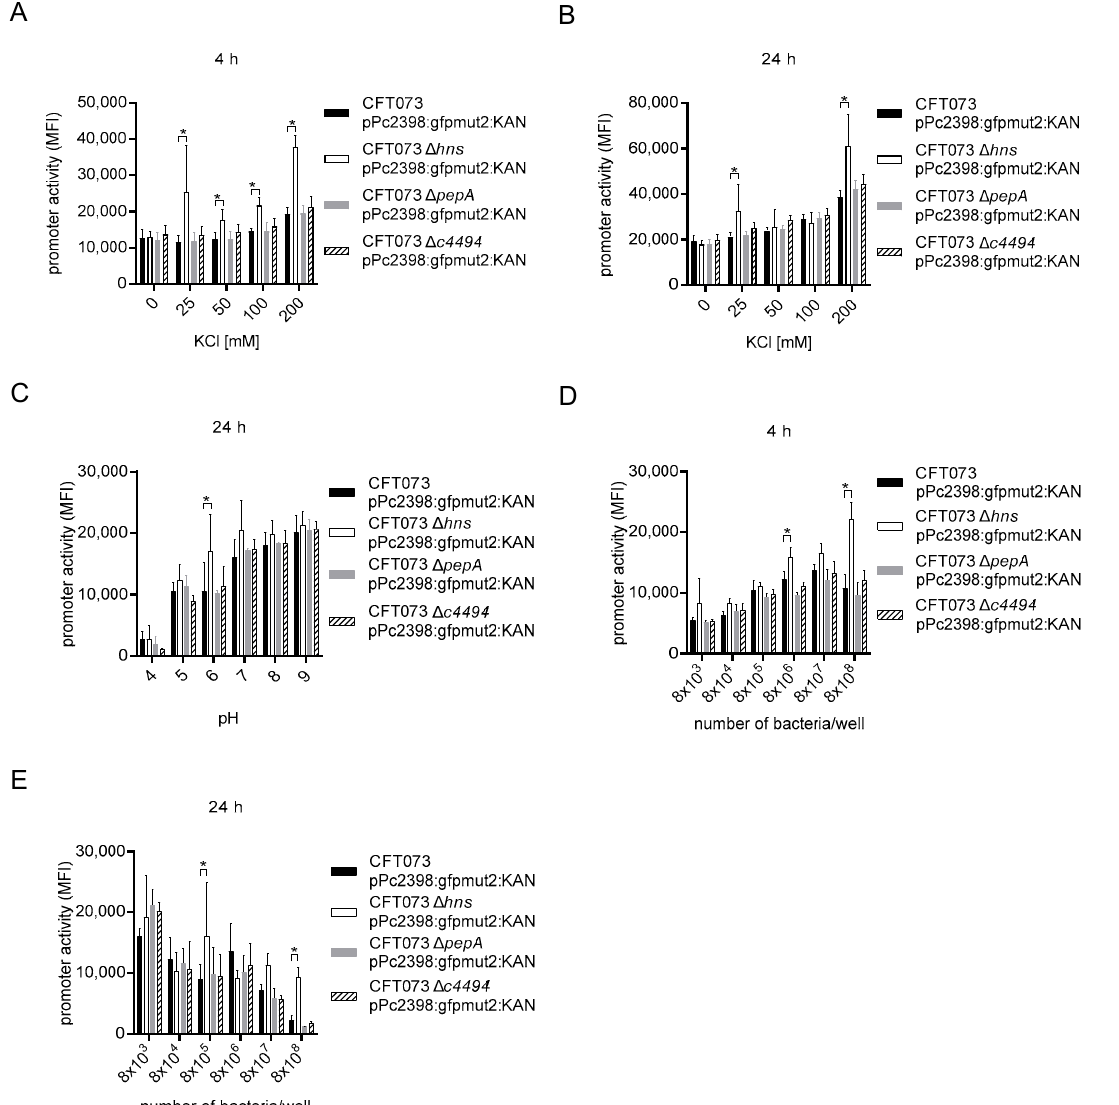
Figure 8. H-NS acts as negative regulator of P2. We cultured CFT073 pPc2398:gfpmut:KAN (over- night culture diluted 1:6), CFT073 Δ hns pPc2398:gfpmut:KAN (overnight culture diluted 1:6),